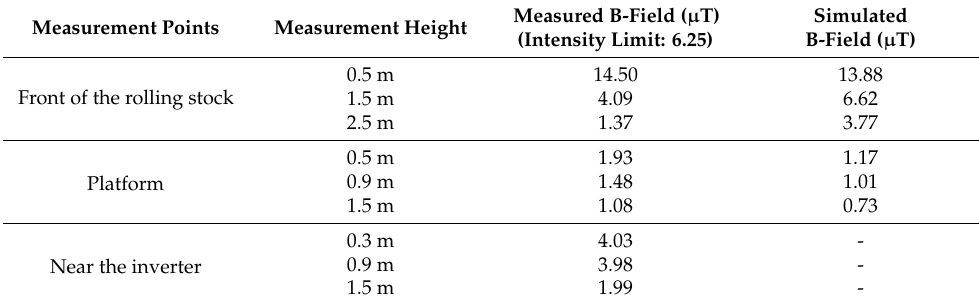
Table 4. Magnetic fields measured outside the rolling stock and surrounding infrastructure. Measurement